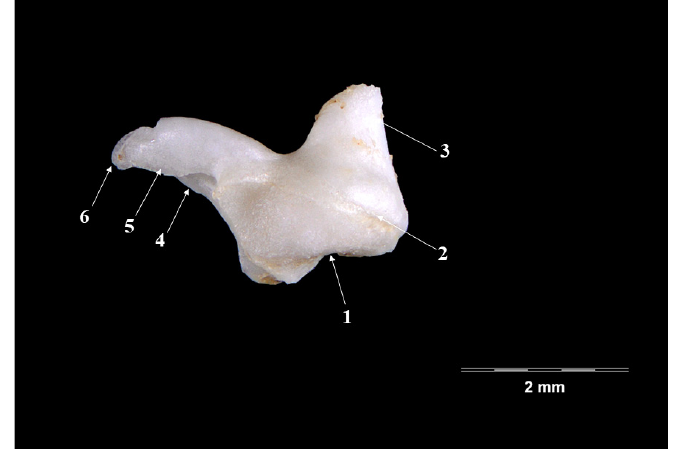
Figure 4. Incus- lateral perspective 1. Incundomalearis articular surface; 2. Corpus incundis; 3. Crus breve; 4. Crus longum; 5. Bony blade; 6. Processus lenticularis.